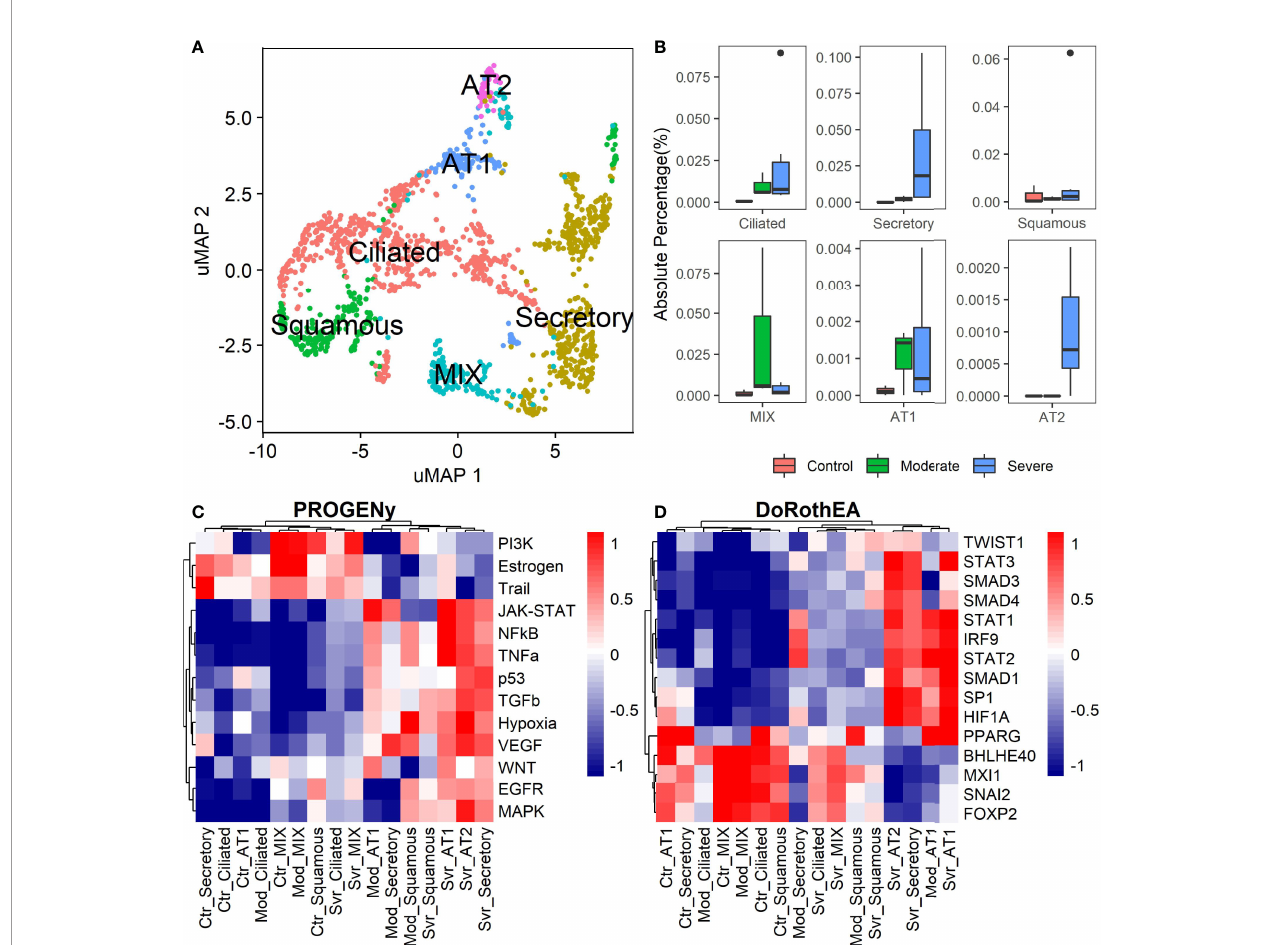
FIGURE 4 | Epithelial cells diversity analysis. (A) Umap projection of epithelial cells data showing the fi ve cell subtypes identi fi ed based on biomarkers: ciliated, secretory, squamous, alveolar type I (AT1), and alveolar type II (AT2) ( Table S2 ). (B) Proportions of the epithelial subtypes among healthy controls, moderate and severe patients. (C) Pathways activation/inactivation analysis with PROGENY for the epithelial cells subtypes considering health status. (D) Activation/inactivation analysis considering health status for the TFs discussed on the whole-epithelial analysis (TFs denoted in purple along with Figure 3B ). Colorbar is related to activation (red) and inactivation (blue) values. Ctr, Mod, and Svr stand for healthy control, moderate and severe